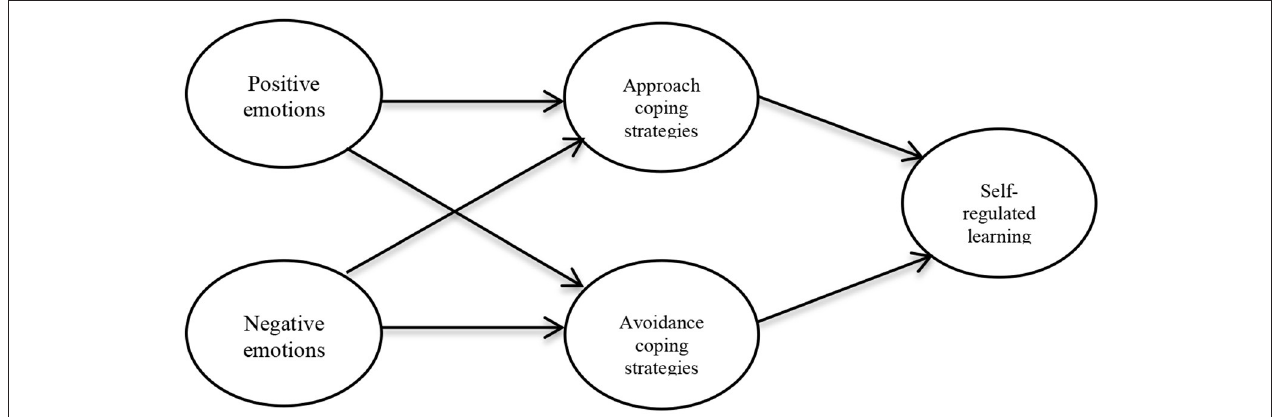
FIGURE 1 | Hypothetical mediation model of coping strategies between emotions and self-regulation of